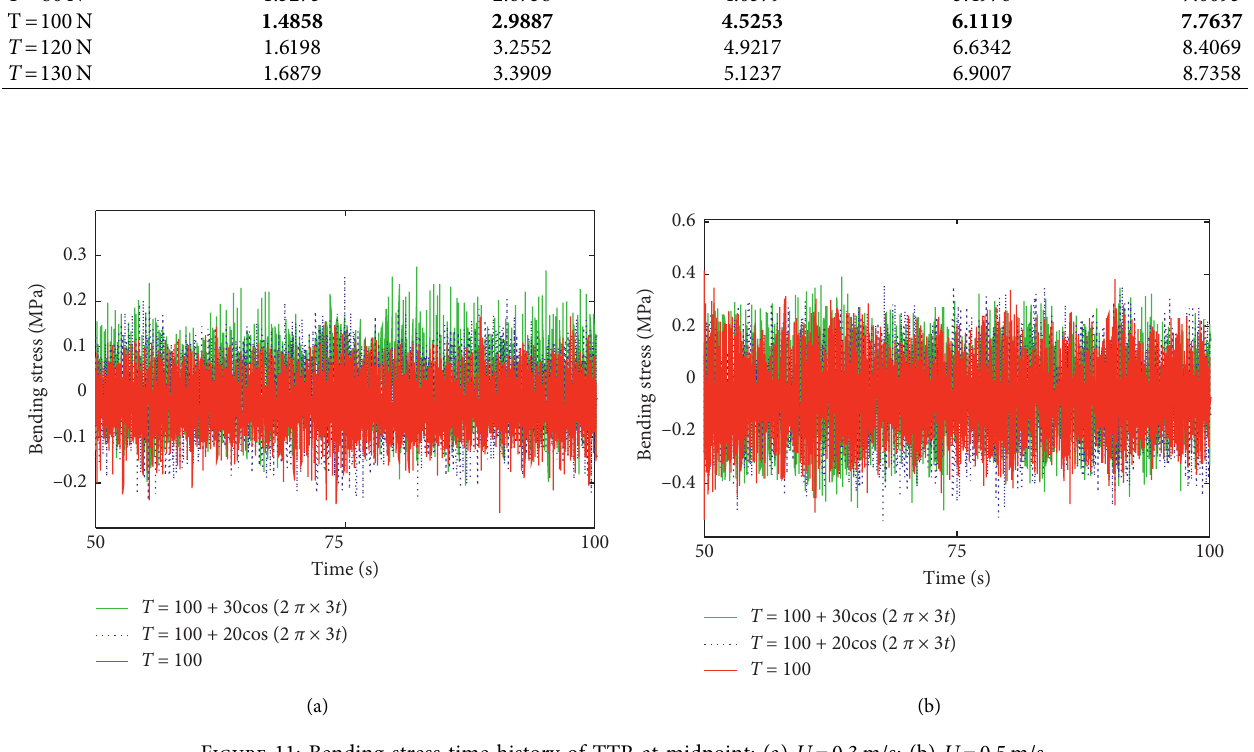
Figure 11: Bending stress time history of TTR at midpoint: (a) U � 0.3 m/s; (b) U �